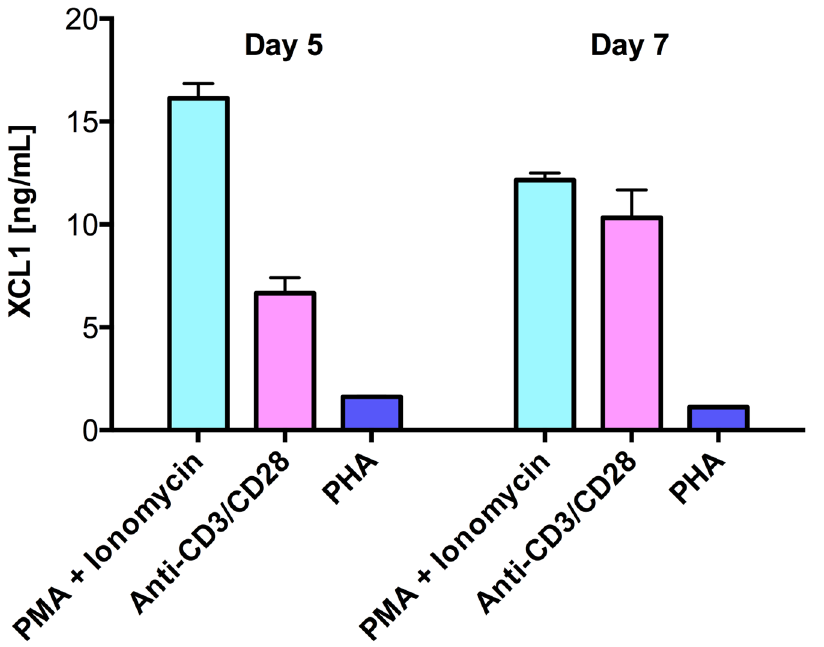
Figure 1. Primary human CD8 + T cells secrete XCL1. CD8 + T cells were activated with three different stimuli for 3 days: PMA plus ionomycin, anti-CD3/CD28 loaded beads, or PHA. Cells were washed and culture supernatants were harvested after 5 and 7 days to quantify XCL1 secretion.